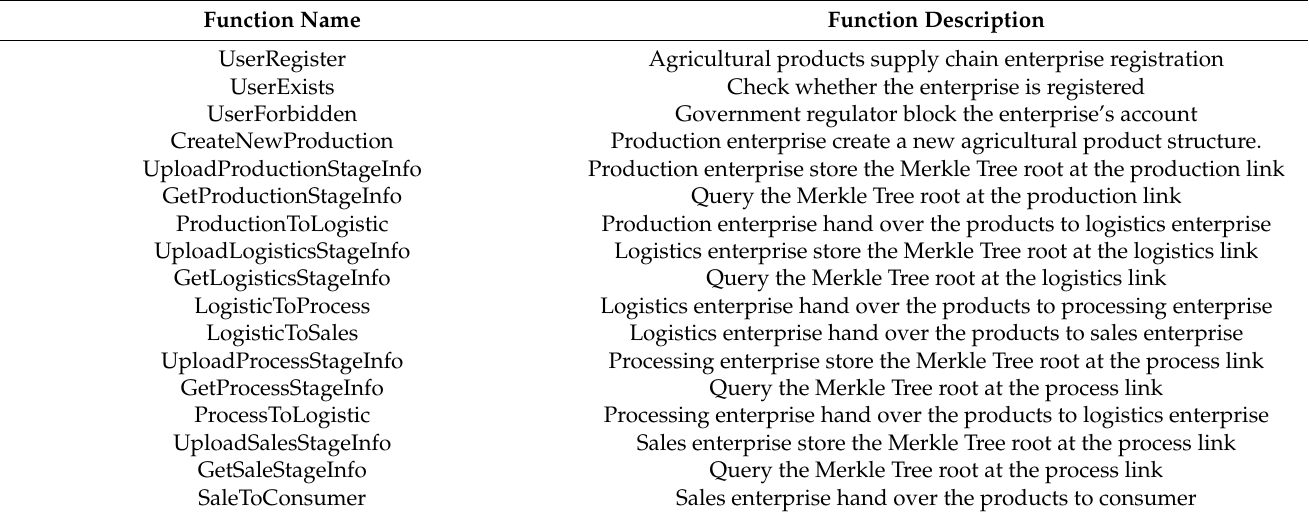
Table 4. The main functions of smart